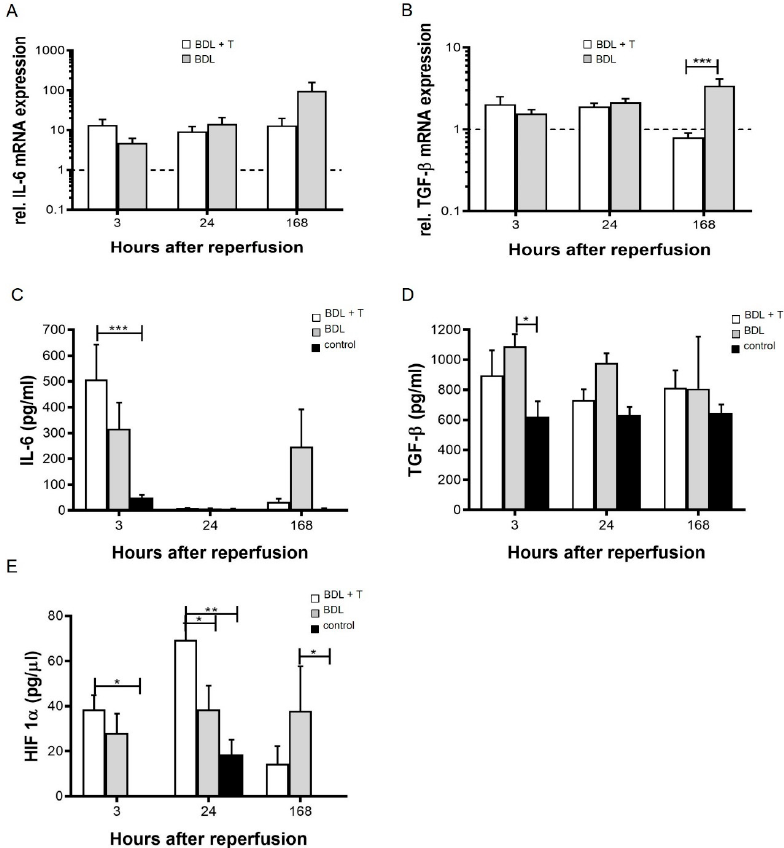
Figure 3. As an important feature of tissue fibrosis and epithelial–to–mesenchymal transition (EMT) pro-inflammatory cytokines ( A , B ) interleukin (IL)-6, ( C , D ) transforming growth factor- β (TGF- β ) mRNA, and protein levels and the ( E ) hypoxia-inducible factor-1 α (HIF-1 α ) levels were analyzed in serum 3, 24, and 168 h after reperfusion. Mean and standard deviation are shown in each group with significance levels of * p < 0.05, ** p < 0.01, *** p < 0.001. Transforming growth factor- β (TGF- β ) serum levels in the BDL group tended to be higher than that of the other two groups (Figure 3D). However, there were no significant differences among the three groups at each time point after reperfusion except for time point at 3 h, here TGF- β serum levels in the BDL group was significantly higher than in the control group. In summary, the control group showed the lowest values of IL-6 and TGF- β throughout the observation period.